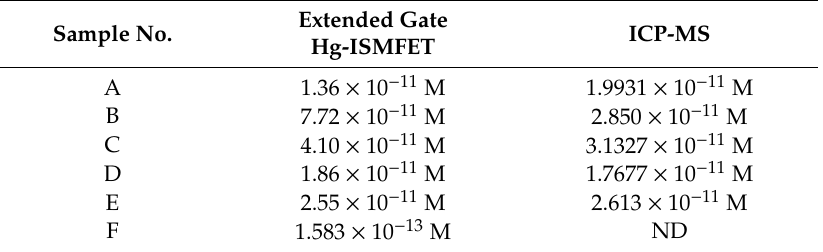
Table 1. Comparison of results obtained from ICP-MS and extended gate Hg-ISMFET.